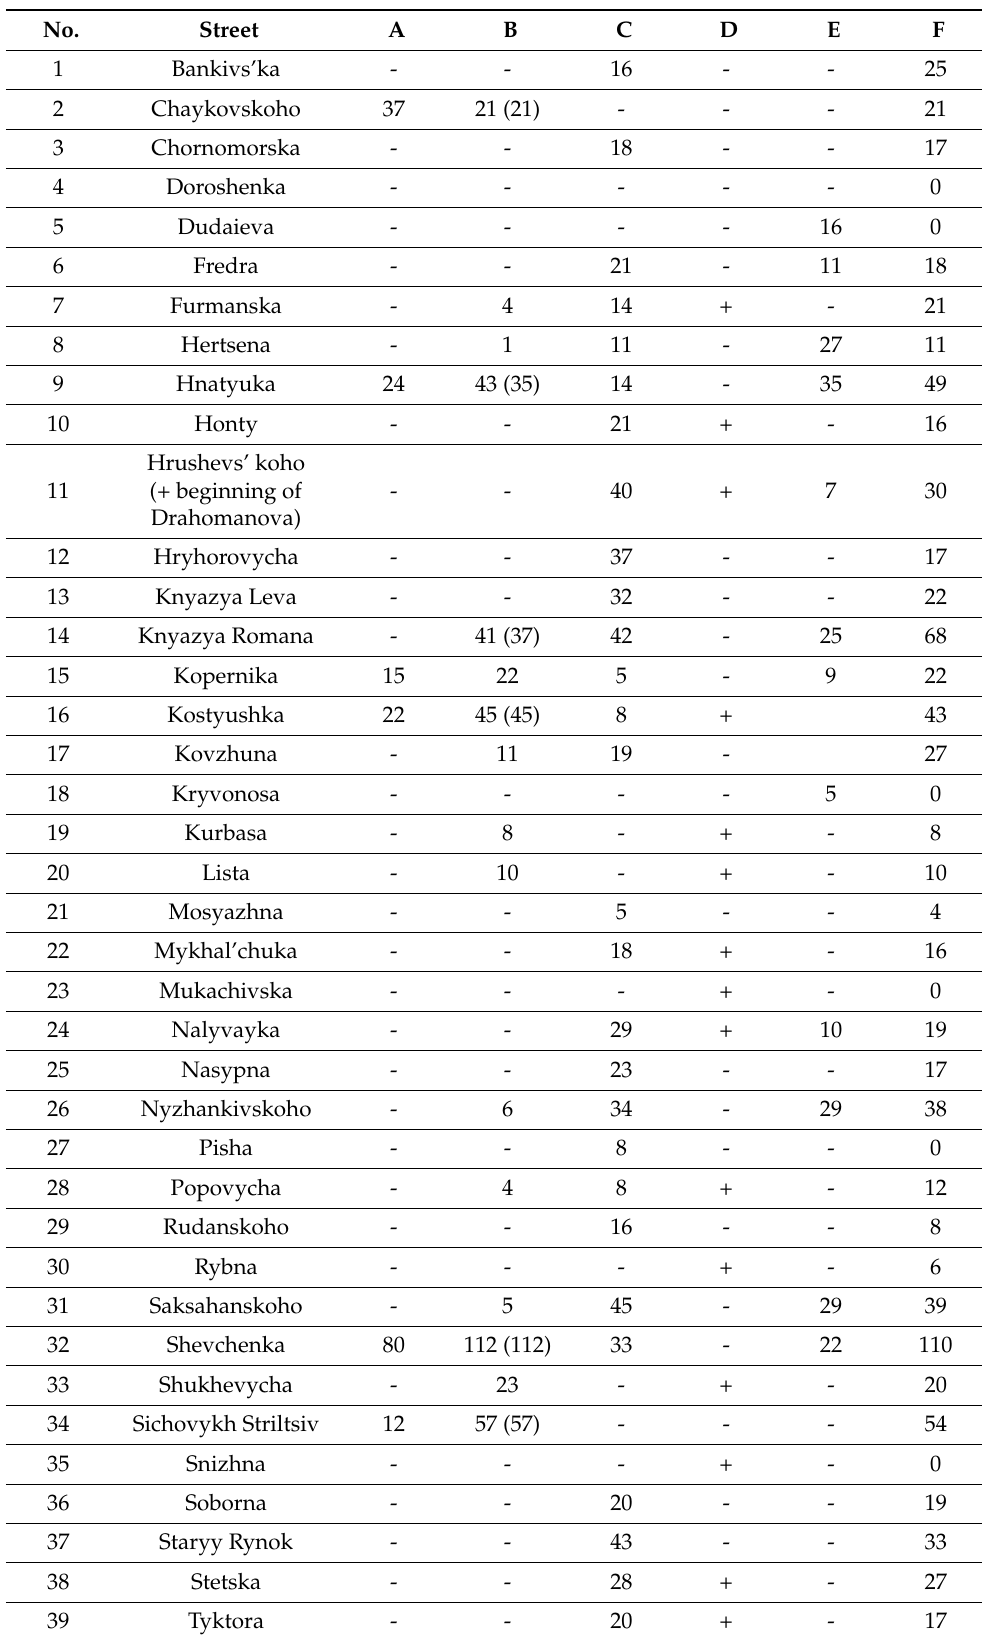
Table 2. Results of the on-street parking field survey in the city center, 2016.